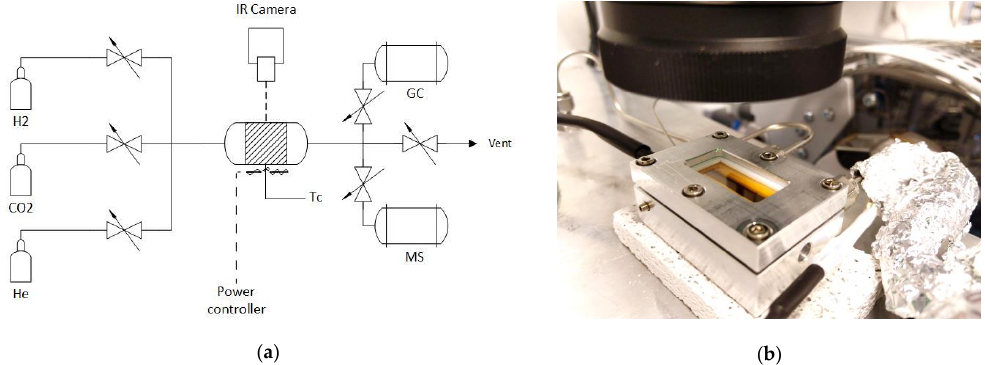
Figure 9. ( a ) Schematic representation of the experimental setup; ( b ) a picture of the reaction cell in the focal view of the IR camera.